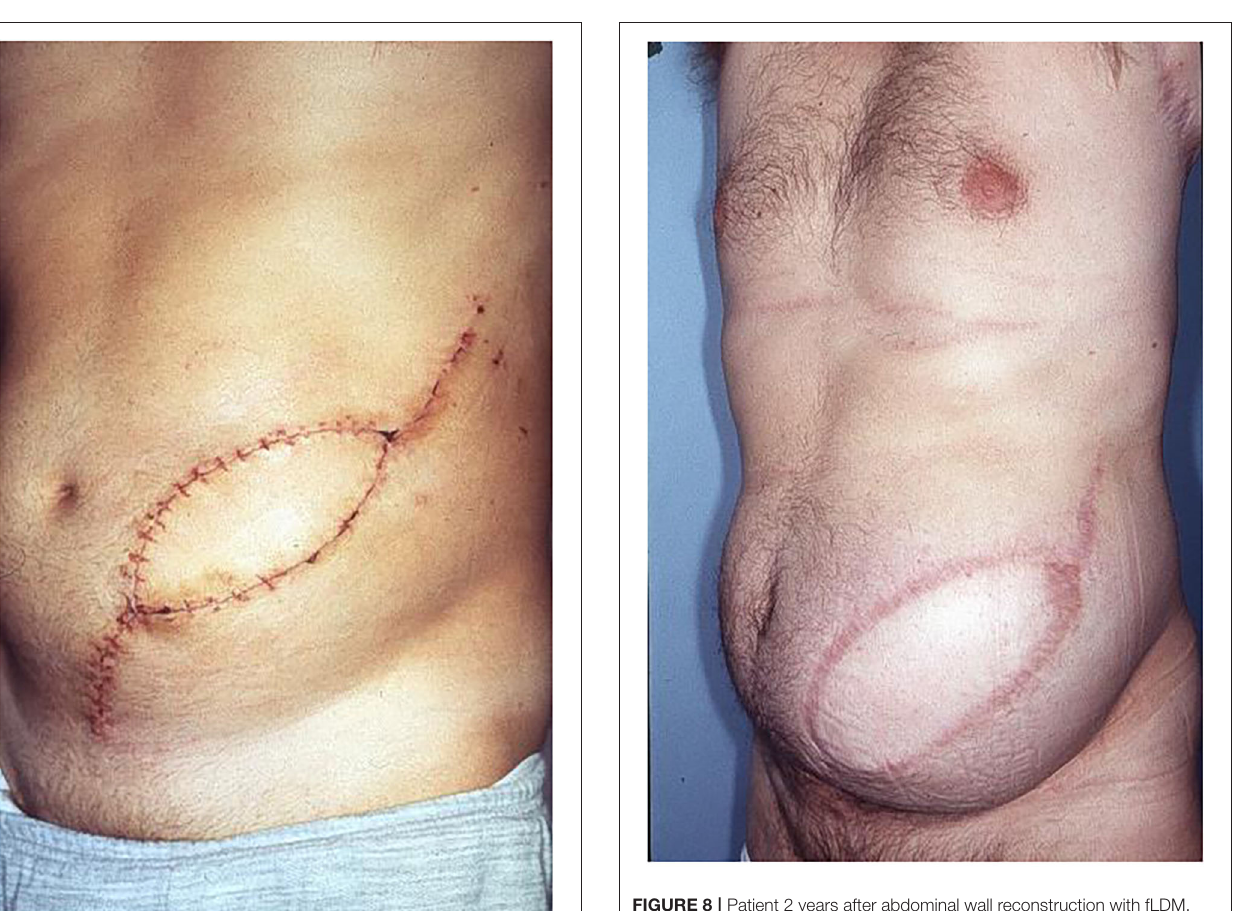
FIGURE 8 | Patient 2 years after abdominal wall reconstruction with